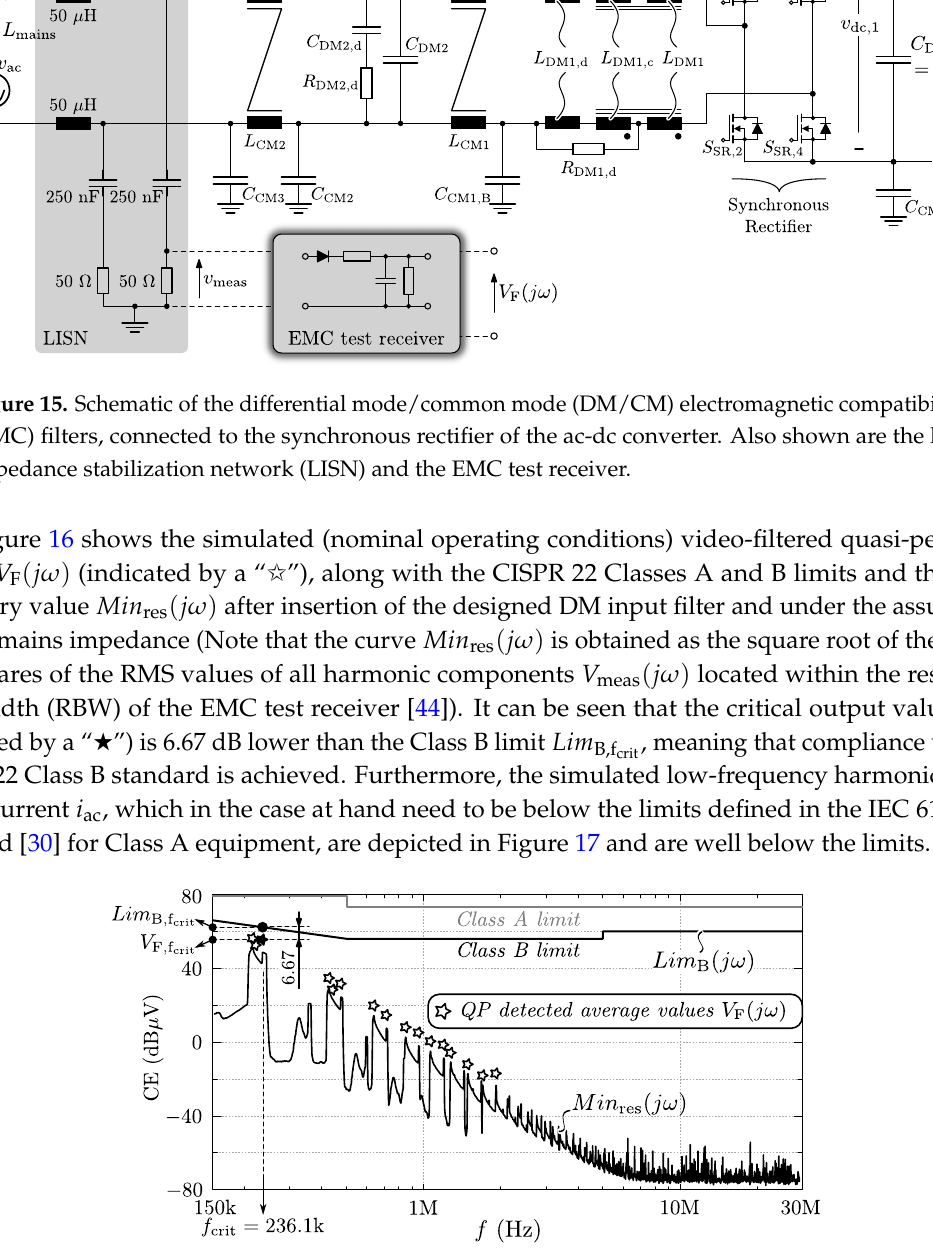
Figure 16. Simulation of the quasi-peak (QP) measurement after insertion of the designed differential mode (DM) input filter and under the assumption of zero mains impedance. Also shown is the absolute lower boundary Min res ( j ω ) for the measurement result and the conducted emission (CE) limits according to CISPR 22 Classes A and